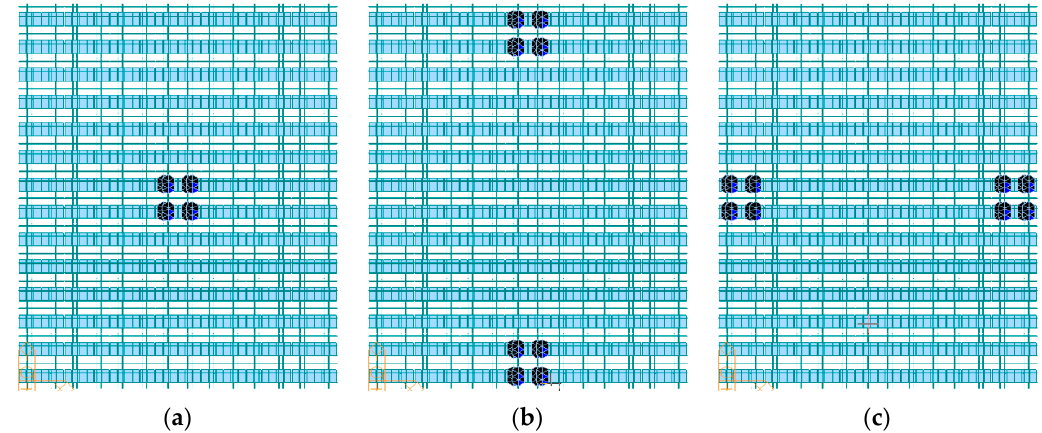
Figure 13. Finite element analysis (review of wave-height impact). ( a ) Case 1; ( b ) case 2; ( c ) case 3.